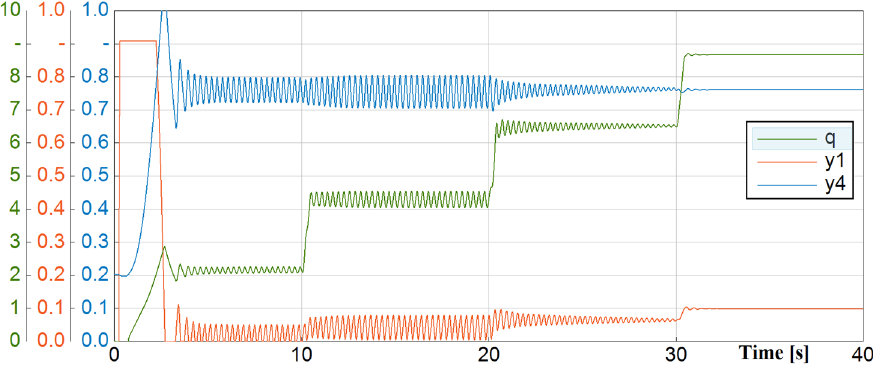
Figure 9. Time responses for flow rate q , valve displacement y 1 and output pressure y 4 with a stepwise increase of the area of metering valve 8 at the constant values of leakage, areas of throttles 10 and 11, and outlet cavity stiffness ( A th 1 = A th 2 = 1.77 mm 2 ; Q leak = 16 l / min ; β out = 3.3 · 10 − 3